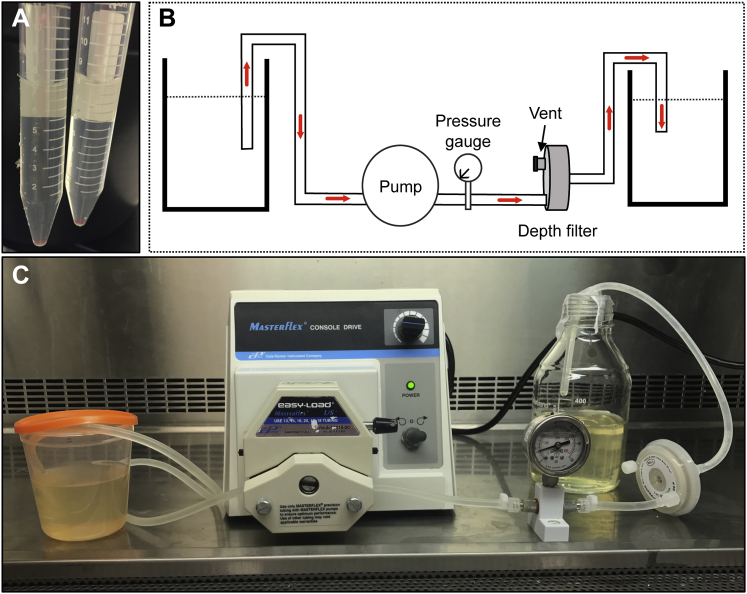
Depth Filtration Setup(A) An example of contaminant-free allantoic fluid suitable for TFF. (B) Schematic of a typical depth filtration setup. (C) Image of a batch of NDV containing allantoic fluid being depth filtered. Note the placement of the pressure gauge. Allantoic fluid is filtered into a sterile container.